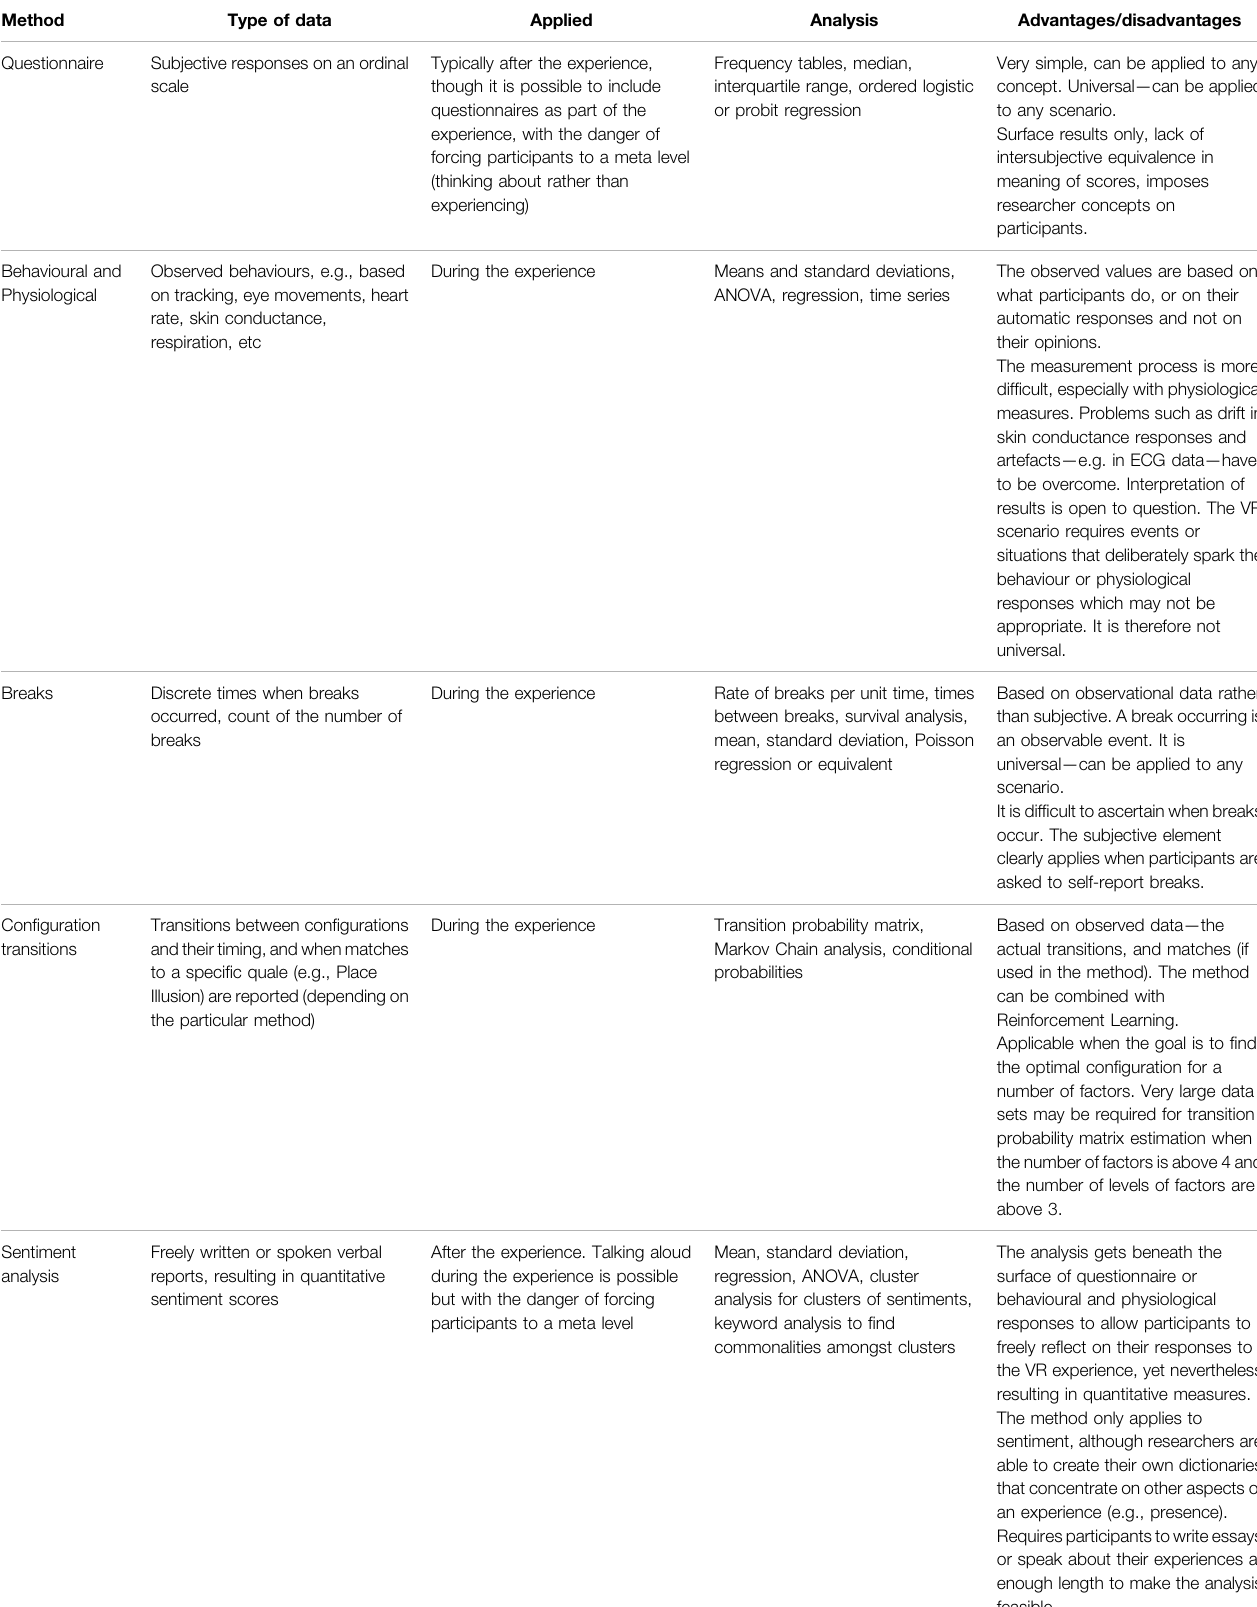
TABLE 1 | Summary of types of measurement and their